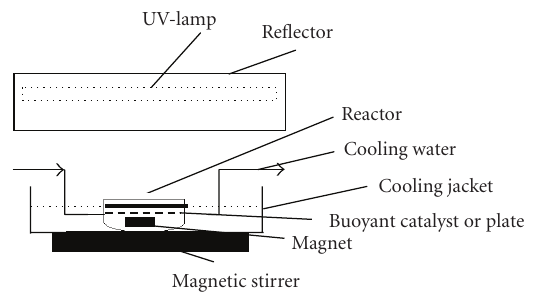
Figure 1: The photocatalytic oxidation experimental